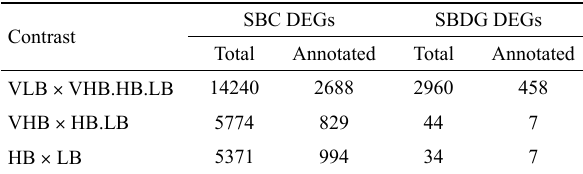
Figure 3 - Effect of sample removal on the results of differential expression. The values represented by the continuous (SBC) and dashed (SBDG) curves are the averages of differential expression tests for all possible combinations and contrasts, as a function of the number of removed samples. The red curve indicates the concordant genes in the original and subsampled datasets; in yellow, the differentially expressed genes with inverted results, whether up or downregulated; in green, genes that were not significant due to subsampling; in blue, filtered genes after subsampling; and in purple, genes that appeared as spuriously differentially expressed with subsampling. Table 2 – The differentially expressed genes (DEGs) in the high confidence set. We identified these genes as differentially expressed in at least 95% of the subsampling combinations when removing from one to four samples in each strategy. We considered only the combinations which presented a minimum of two samples per experimental group. For each strategy, we show the total number of DEGs and those annotated with gene ontology